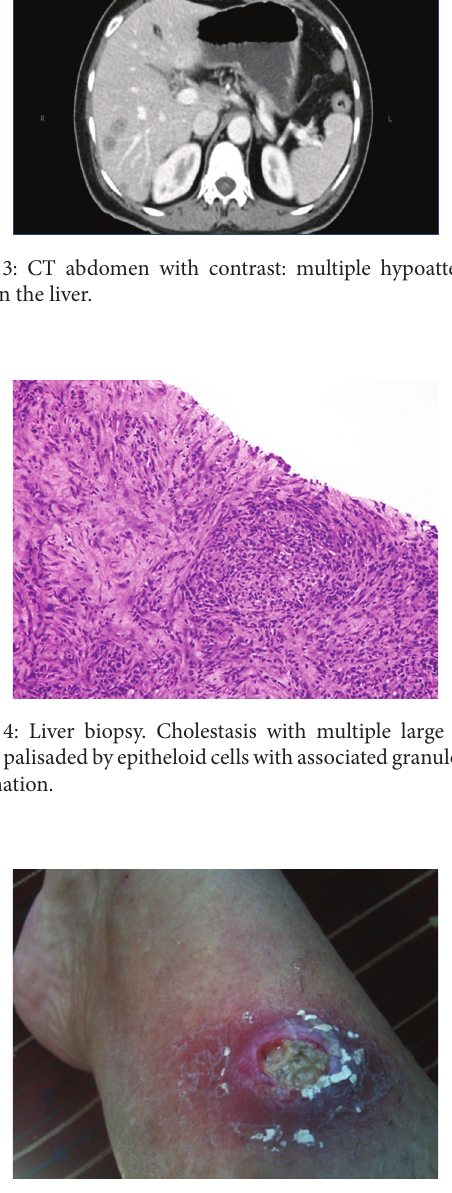
Figure 5: Ulceration in the nodule with erythema and discharge.